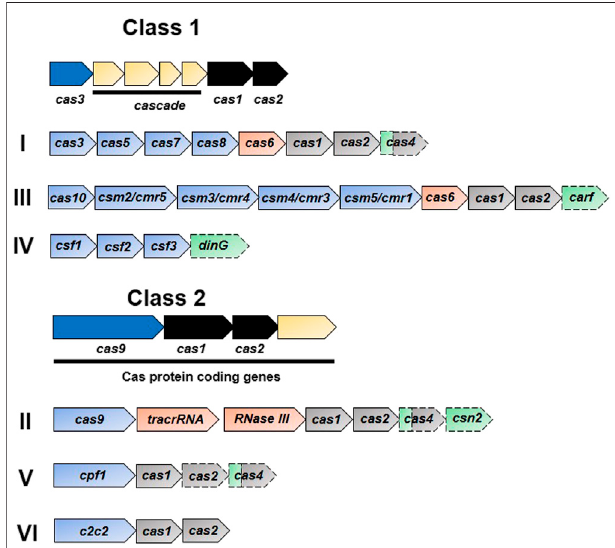
FIGURE 2 | Functional organization of CRISPR systems. The CRISPR/ Cas system has two main classes depending upon the nature of the effector nuclease complexes: class 1 has a multi-protein complex while there is single main protein in class 2. Each class is further subdivided into three main types based upon the signature and complementary genes. Representative operons speci fi c to each type are shown in the fi gure. Dispensable elements arerepresentedbyadashed outline,while thetwocolorsforcas4 indicate the involvementofgeneproductintwostages.Genesinvolvedintheinterference, crRNA-synthesis, adaptation, and accessory role are represented in blue, orange, black, and green, respectively.